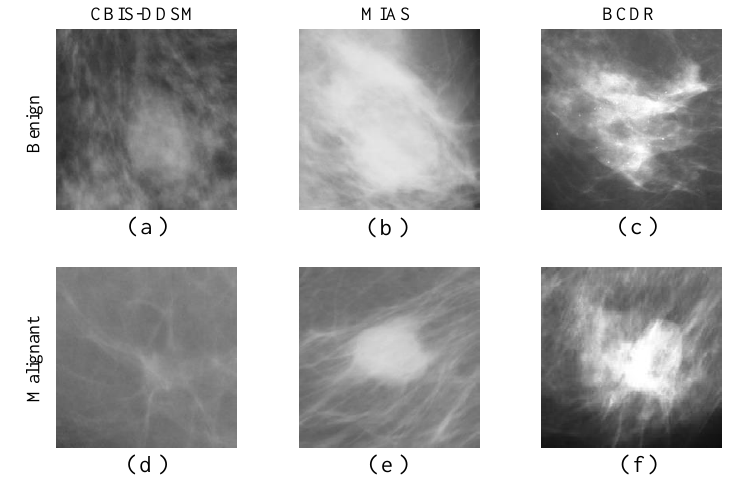
Figure 2. Datasets examples. Benign cases are shown in ( a – c ). Malignant cases are shown in ( d – f ). ( a , d ) represent samples from the curated breast imaging subset of digital database screening mammography (CBIS-DDSM) dataset, ( b , e ) represent samples from the mammographic image analysis society (MIAS) dataset, and ( c , f ) represent samples from the breast cancer digital repository (BCDR)